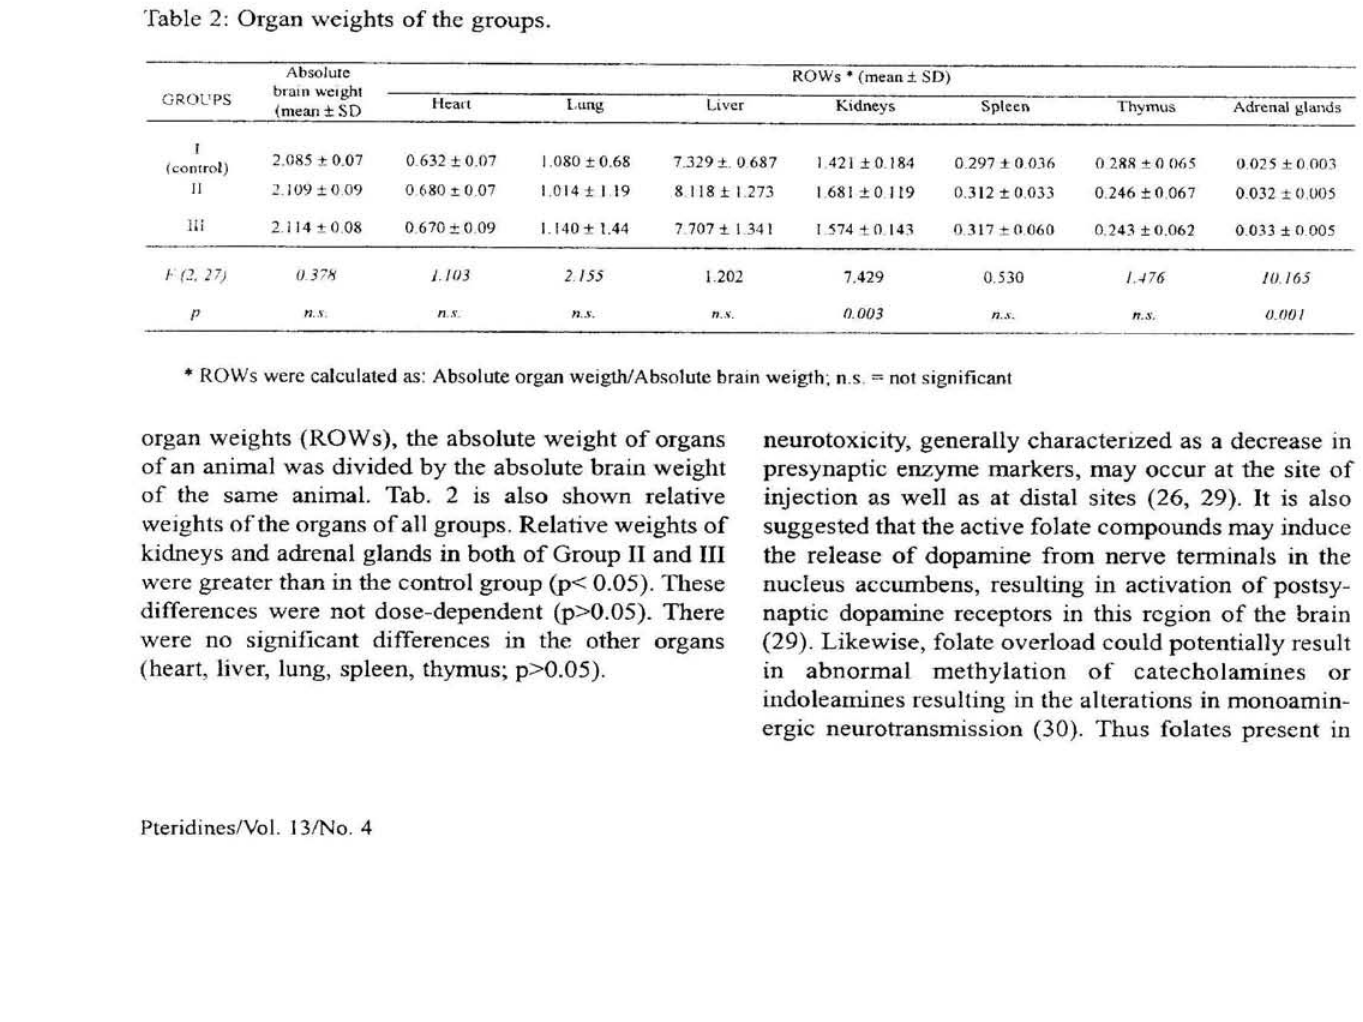
Table 2: Organ weights of the groups.